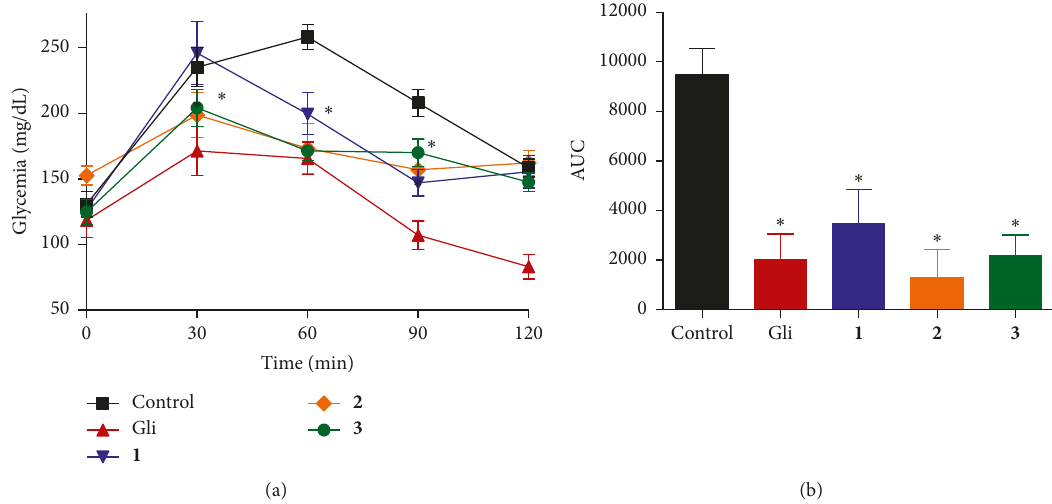
Figure 4: Oral glucose tolerance test (a) and AUC (b) of heterocycles 1–3 . ∗ Statistical significance compared with control ( n � 6, mean ± SEM, p < 0 . 05).